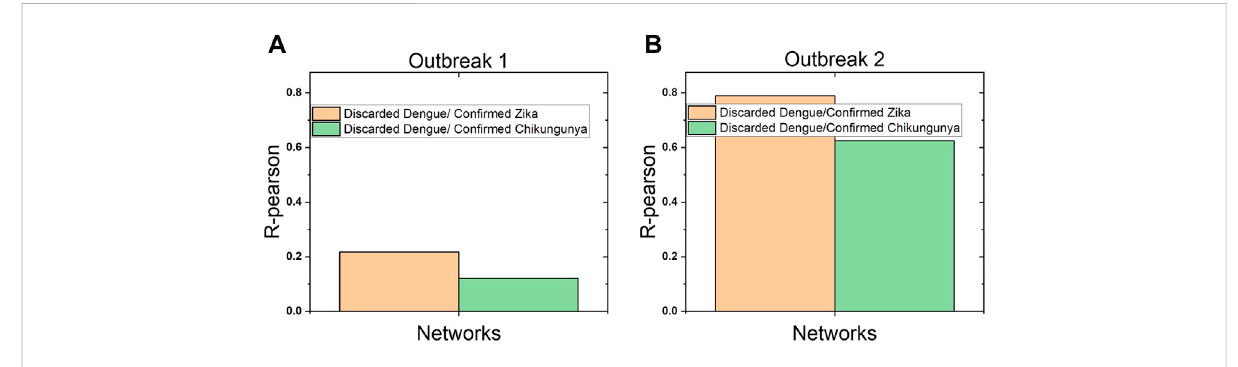
FIGURE 11 Pearson correlation coef fi cient (R-Pearson) of the temporal evolution of the networks of discarded dengue and con fi rmed Zika and chikungunya (A) Outbreak 1. (B) Outbreak